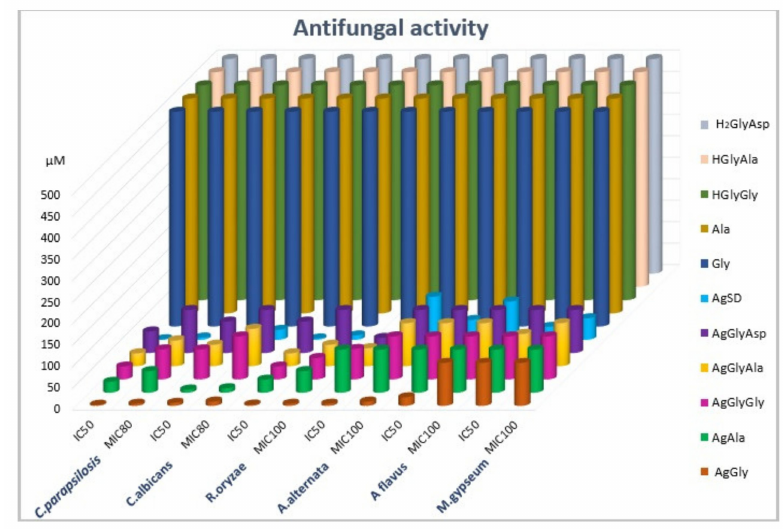
Figure 4. Antifungal activity of silver(I) complexes and free ligands (IC 50 , MIC 90 : µ mol · L − 1